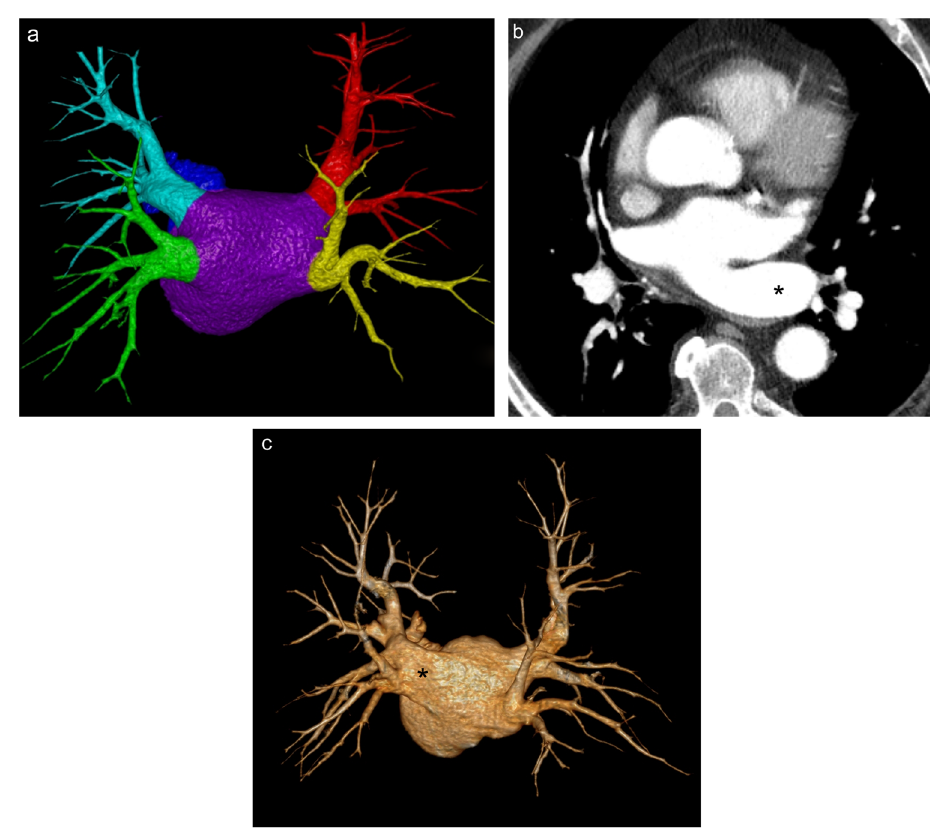
Fig. 11 Pulmonary venous variant. a Three-dimensional re- construction of a contrast- enhanced CT shows normal pul- monary venous anatomy with two right and two left pulmonary veins draining into the left atrium. b Axial CT image showing the most common variant of pulmo- nary venous anatomy, a fusion of the left pulmonary veins prior to entry in the left atrium (*). c Three-dimensional reconstruction shows a fusion of the left superior and inferior pulmonary veins with a shared ostium (*)